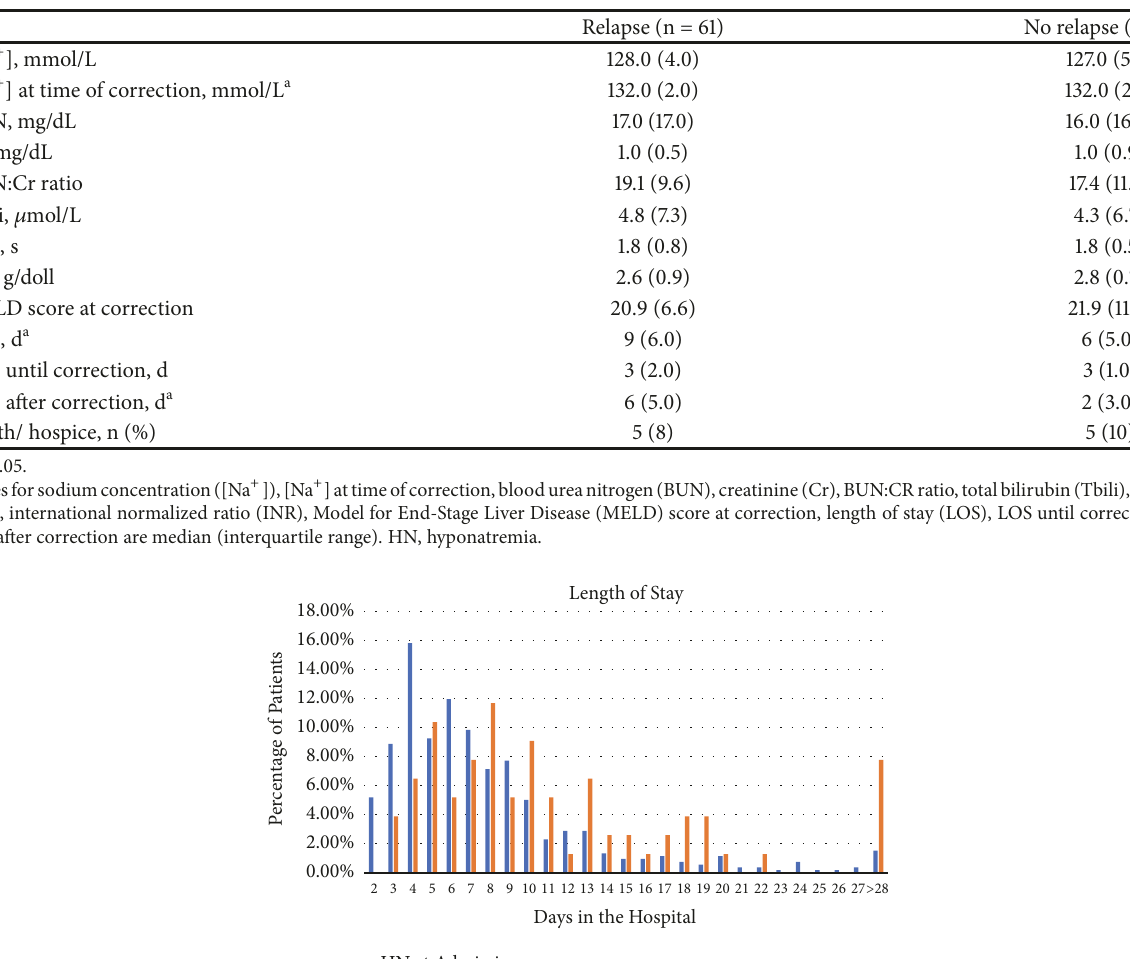
Table 4: Patient characteristics and LOS for patients admitted with HN who corrected with initial HN therapy.